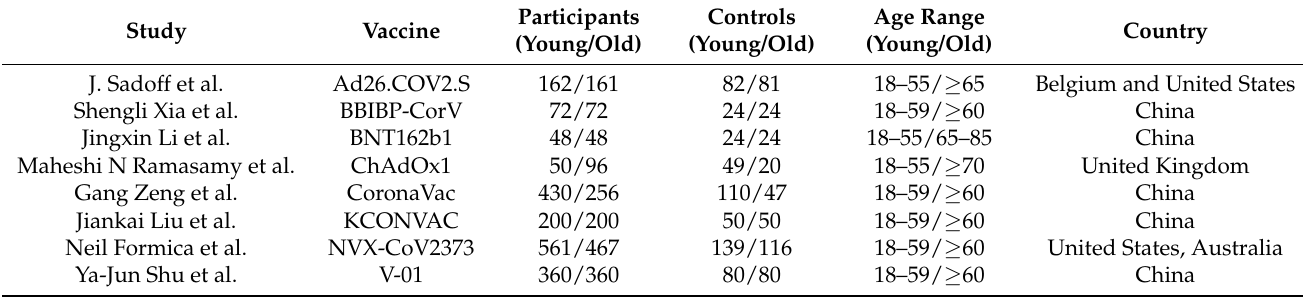
Table 1. Characteristics of included